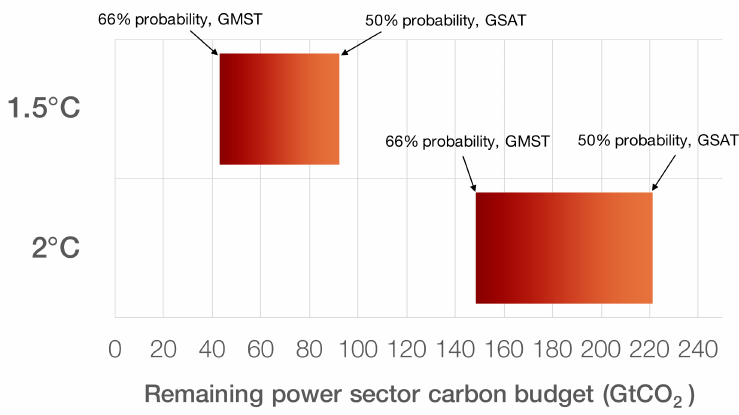
Figure 1. Estimate of remaining power sector carbon budget at the end of